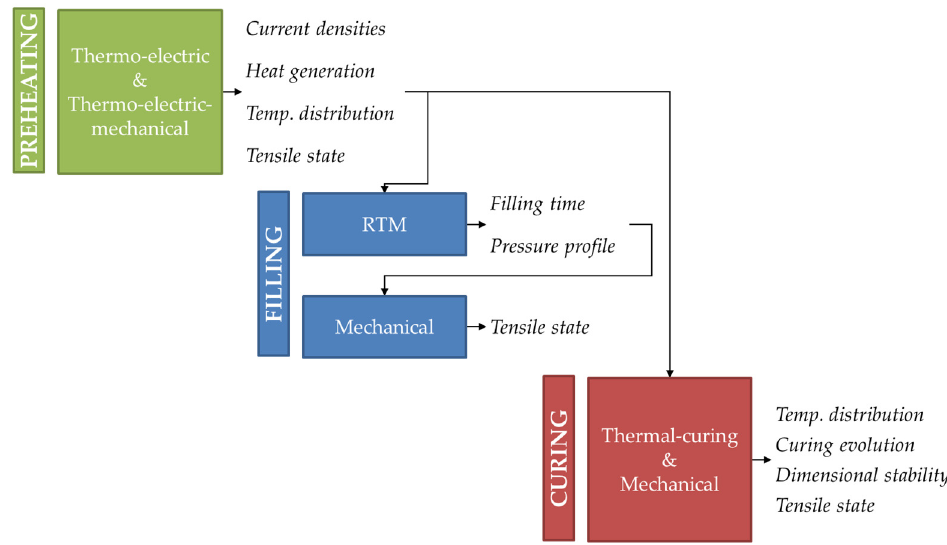
Figure 2. Software framework for the mould design.